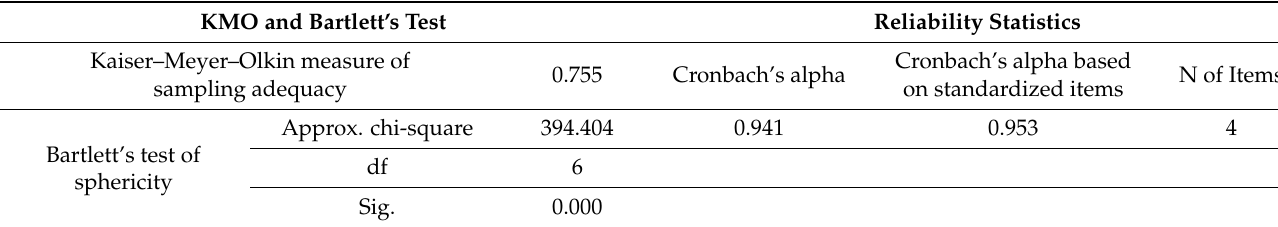
Table 3. KMO and Cronbach’s